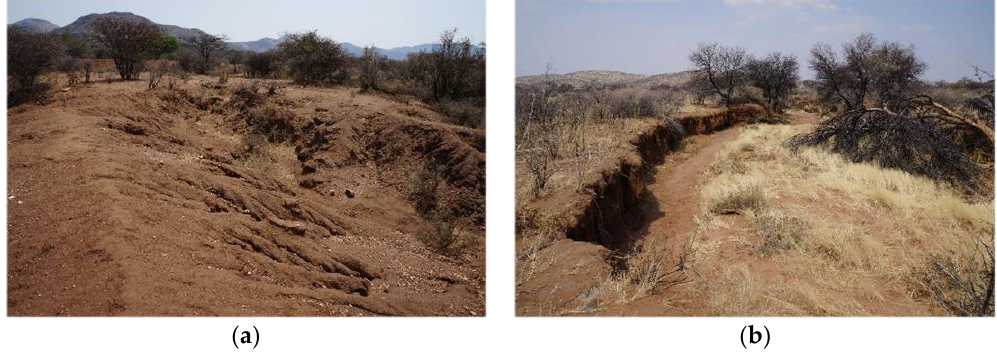
Figure 11. Images from two gully sections enclosed by ( a ) Square 1 and ( b ) Square 2, respectively from the Figure 10.